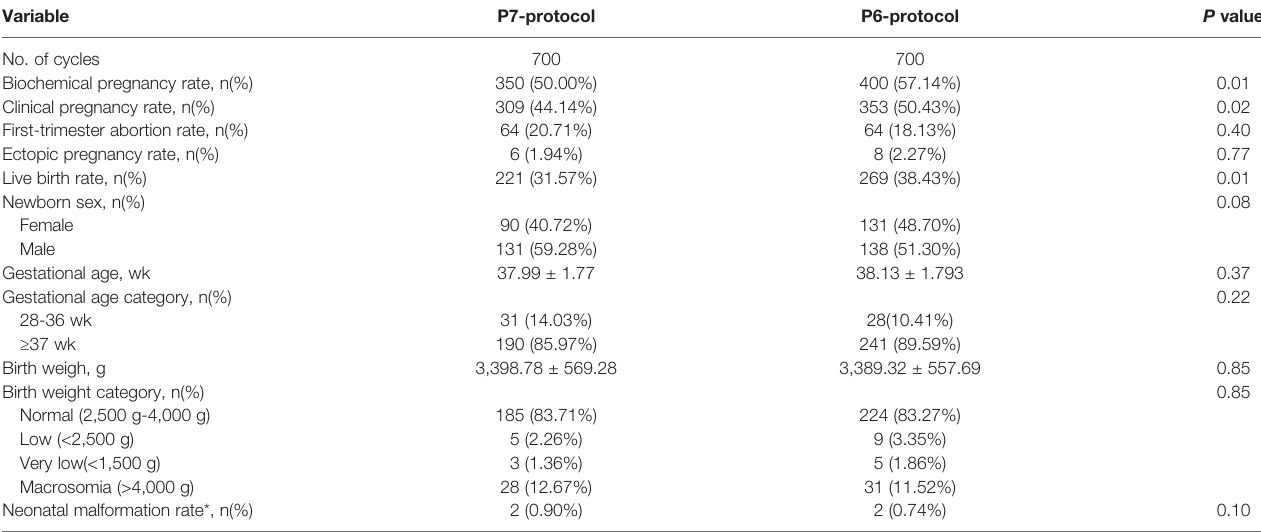
TABLE 2 | Pregnant outcomes in overall PS-matched